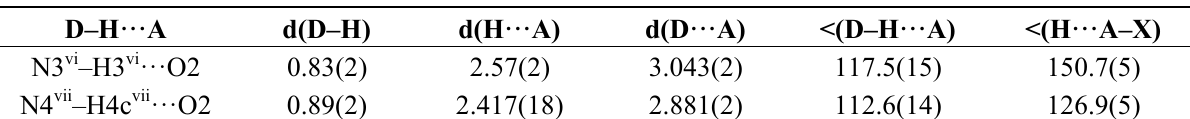
Table 4. Selected hydrogen bonds in the structure of 2 . Symmetry codes: (i) 0.5 + x